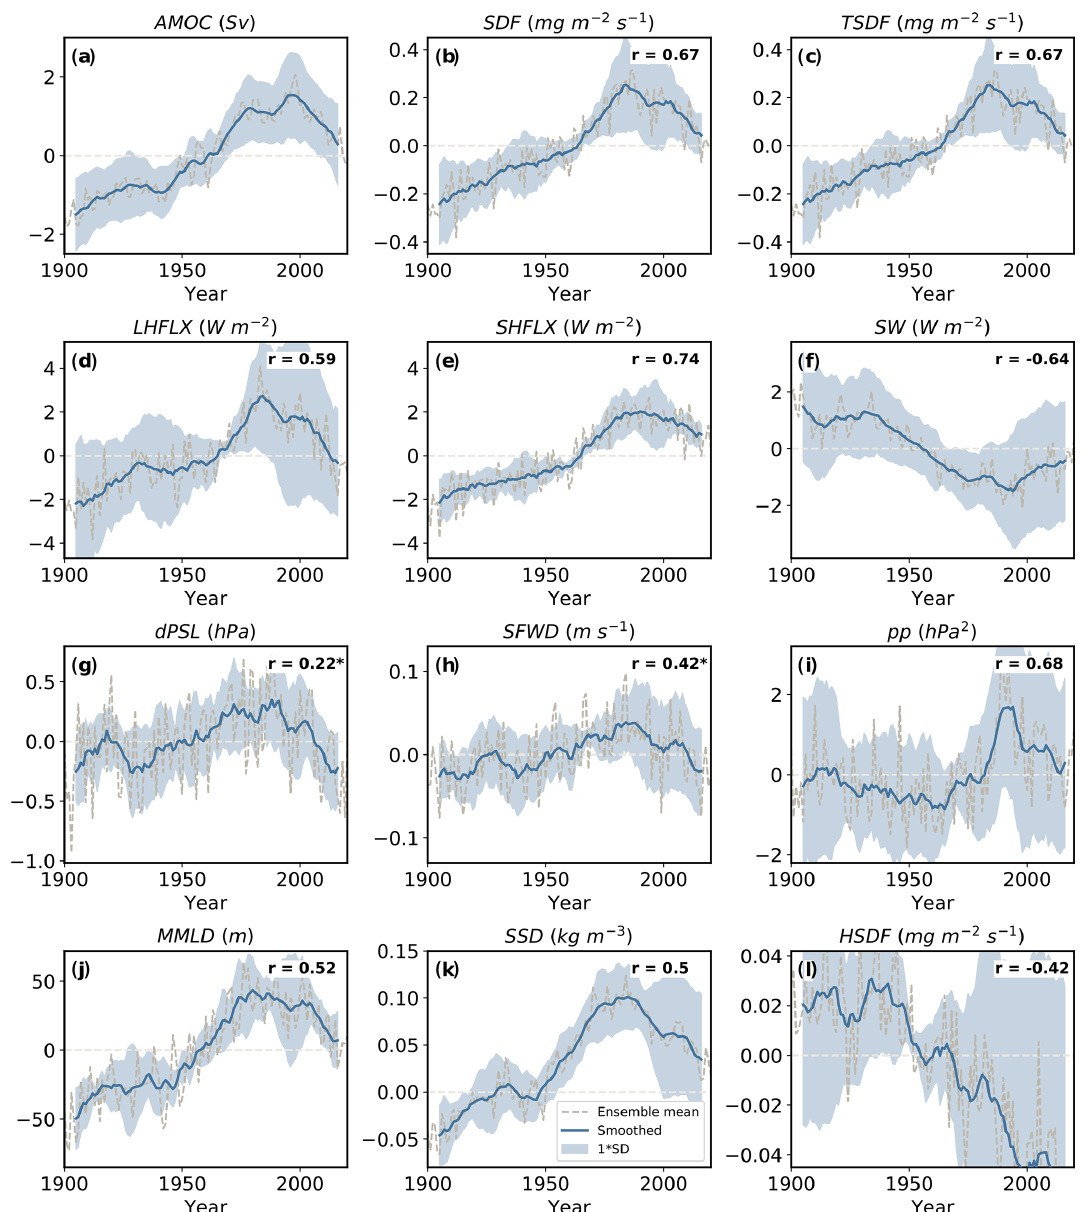
Figure 9. The 1900–2020 ensemble mean annual mean anthropogenic aerosol forcing Coupled Model Intercomparison Project phase 6 normalized time series: (a) Atlantic meridional overturning circulation (AMOC) and subpolar North Atlantic (b) surface density flux (SDF), (c) thermal SDF (TSDF), (d) latent heat flux (LHFLX), (e) sensible heat flux (SHFLX), (f) net downward surface shortwave radiation (SW), (g) sea level pressure gradient (dPSL), (h) surface wind (SFWD), (i) storm track activity (pp), (j) March mixed-layer depth (MMLD), (k) sea surface density (SSD), and (l) haline SDF (HSDF). The ensemble mean time series (dashed gray line) is smoothed using a 10-year running mean (solid blue line). Shading shows the corresponding inter-model standard deviation. The 1950–2020 correlation coefficient against AMOC is shown at the upper right-hand side of each panel, all of which are significant at the 95% confidence level except for those correlations marked with an asterisk. Each model is normalized by subtracting its long-term (1900–2020) climatology. The AMOC is defined as the maximum stream function below 500m in the Atlantic. AMOC values are in sverdrups (Sv), where 1Sv is equal to 10 6 m 3 s − 1 . SDF, TSDF, and HSDF values are in mgm − 2 s − 1 . SHFLX, LHFLX, and SW values are in Wm − 2 . The dPSL values are in hPa, pp values are in hPa 2 , MMLD values are in m, SSD values are in kgm − 3 , and SFWD values are in ms − 1 . The subpolar North Atlantic region is defined as 45–60 ◦ N, 0–50 ◦ W. The dPSL is the Europe–subpolar North Atlantic PSL gradient, defined as 30–45 ◦ N, 0–30 ◦ E minus 45–60 ◦ N, 0–50 ◦